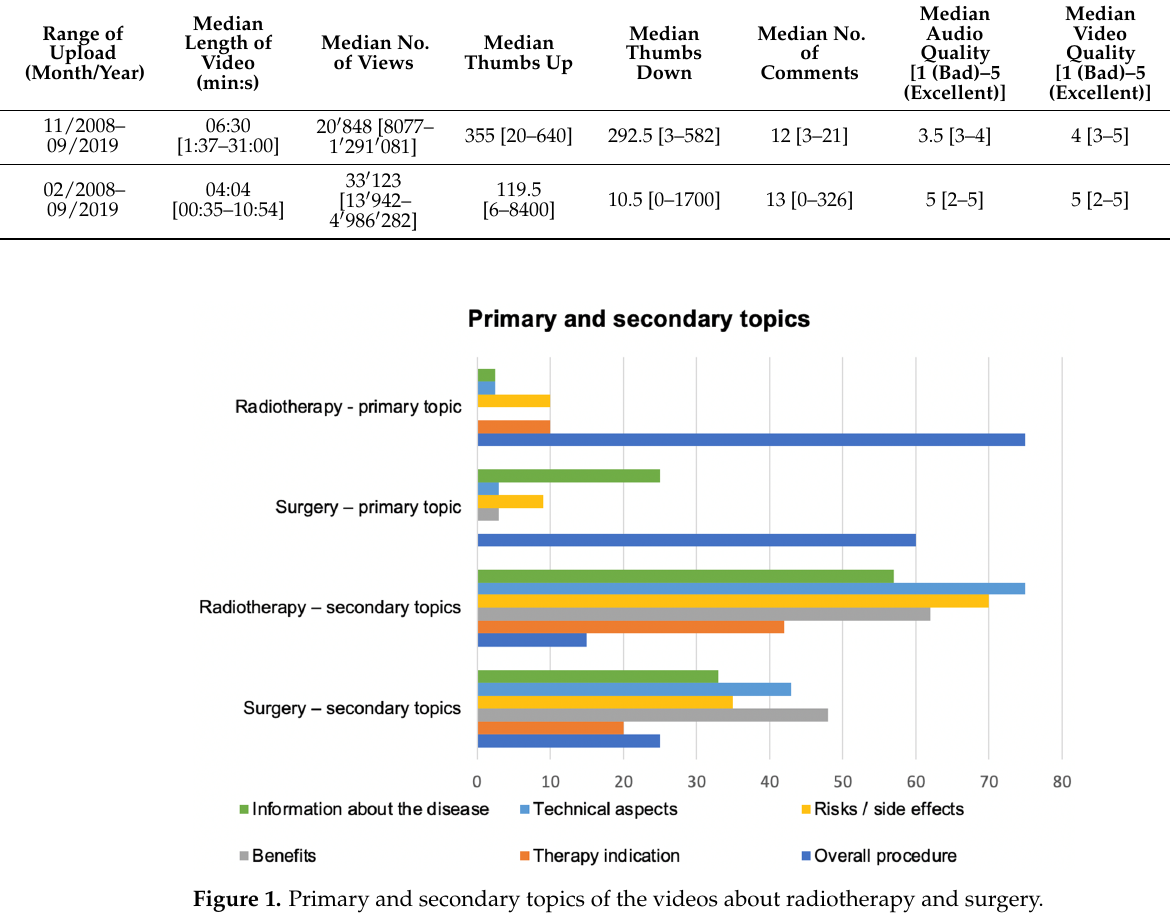
Table 1. Basic characteristic of included videos, grouped by type of treatment (radiotherapy or surgery). (Numbers are reported as median [range] unless indicated otherwise.).